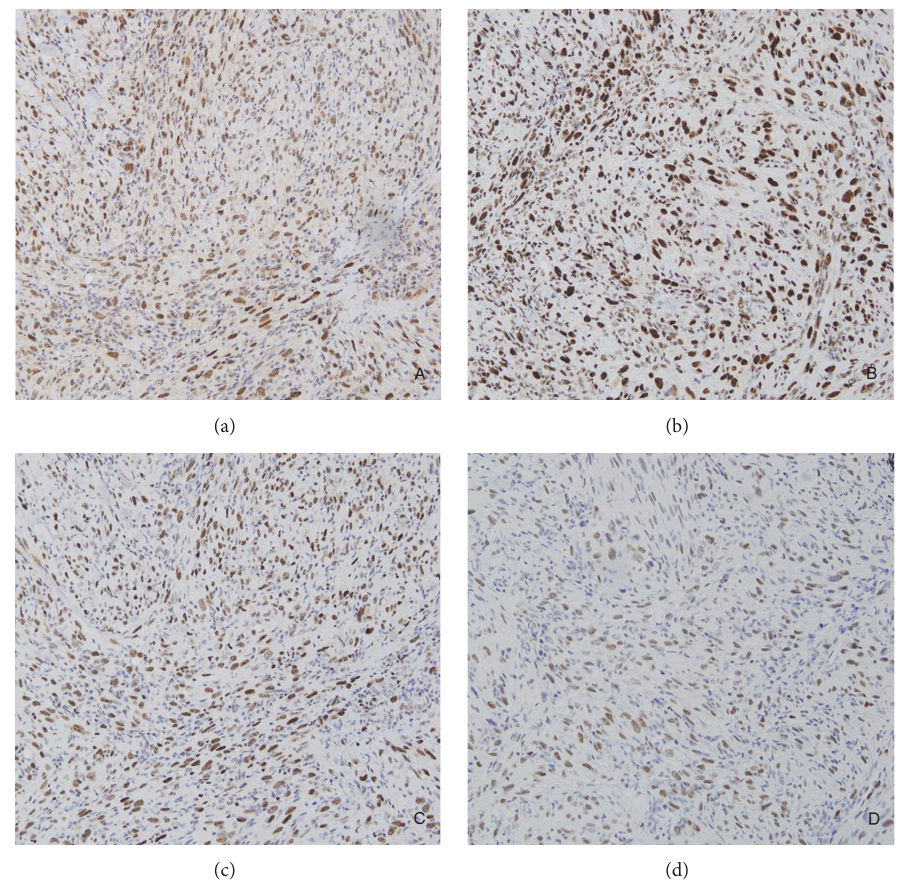
Figure 3: Immunohistochemistry showed positive staining for (a) MLH1+, (b) MSH 2+, (c) MSH6+, and (d) PMS2+. Positive staining indicates the absence of microsatellite instability in this